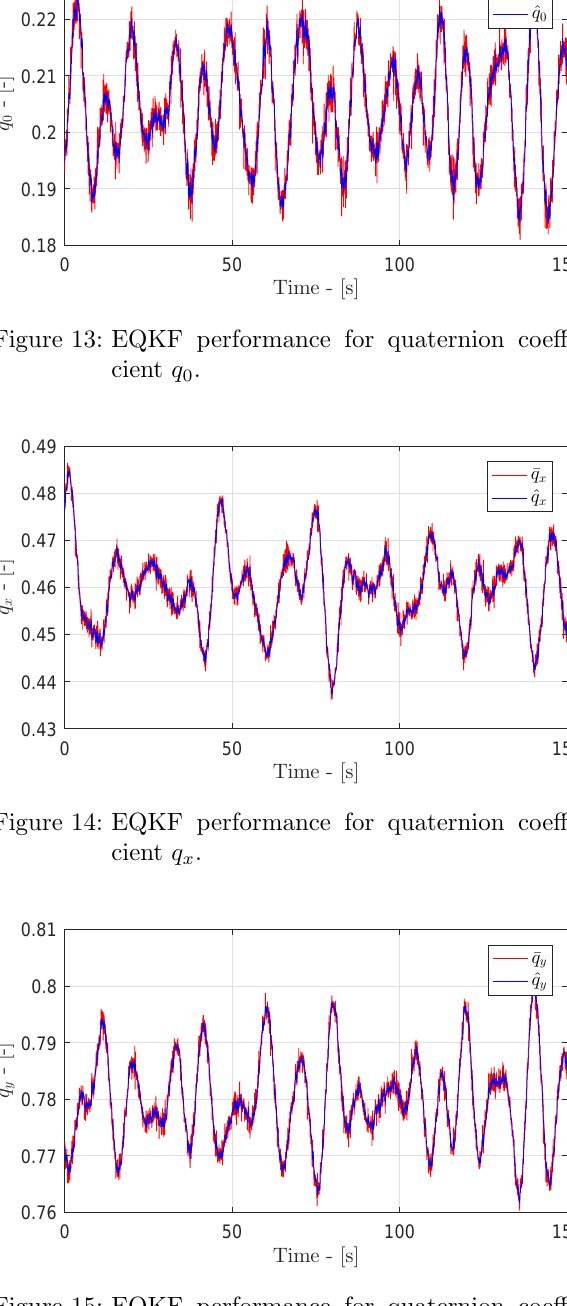
Figure 15: EQKF performance for quaternion coeffi- cient q y